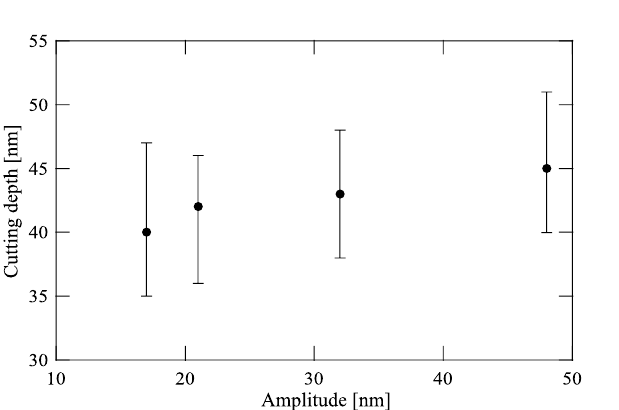
Figure 13. AFM image ( a ) shows four holes marked as I, II, III and IV which were cut under the 400 µ N pressing load by phase difference modulations with the self-excitation cutting method. The four holes were cut while the resistance values in the phase shifter circuit were set at 15 k (cid:31) , 20 k (cid:31) , 25 k (cid:31) and 30 k (cid:31) , respectively. Four lines 1 – 4 in the upper corner are to indicate the locations taken for the sectional views of four holes (cid:31) (cid:31) shown in Fig. 2 in Appendix C and the intersecting sectional views are centered on all holes. ( b – e ) show the magnified depiction for the AFM image of each hole.